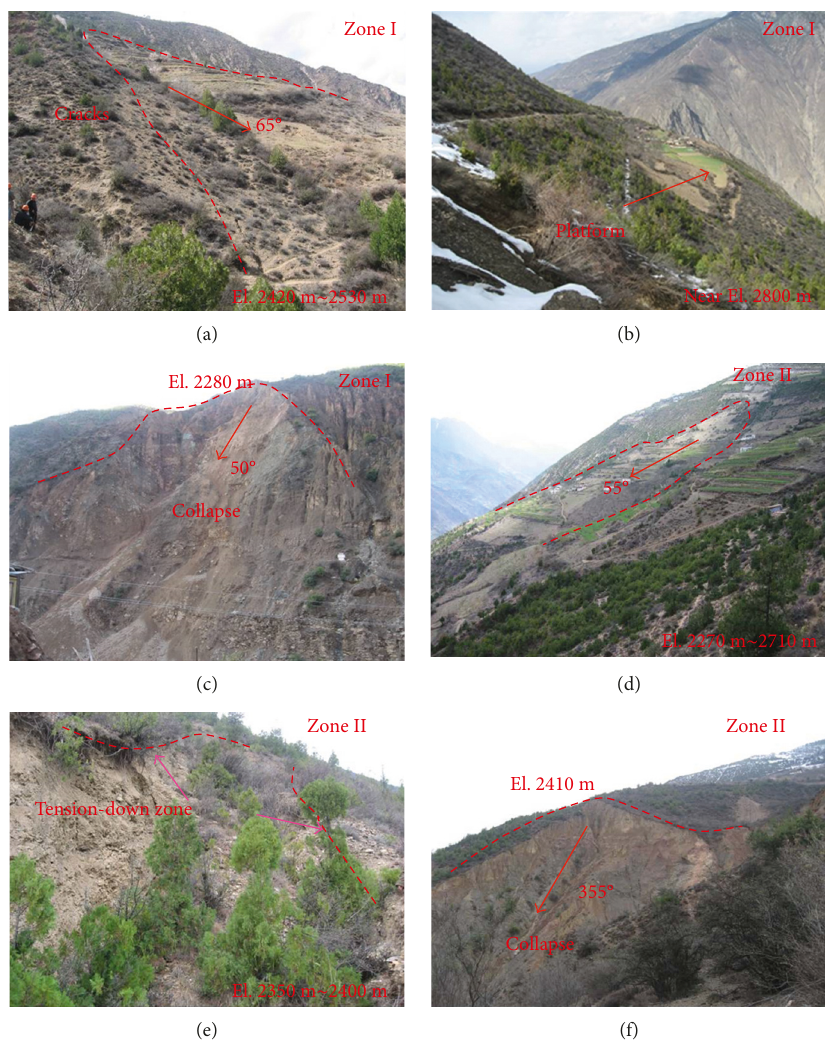
Figure 8: Deformation features of the Zhenggang